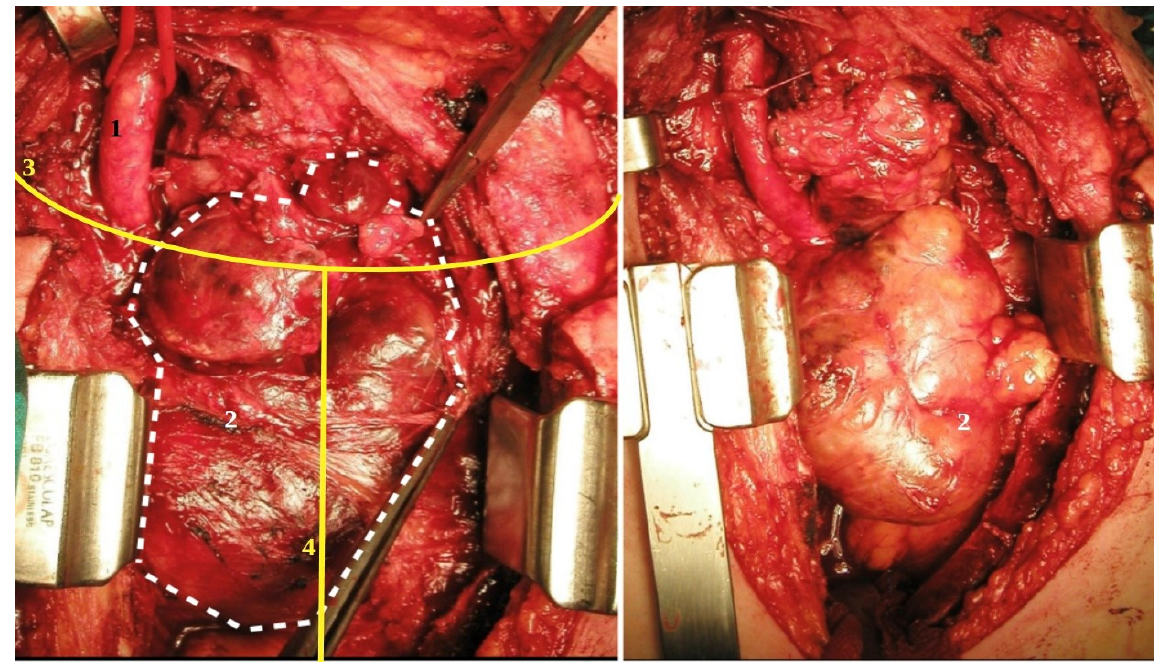
Figure 3. Cervicotomy and sternotomy for endothoracic goitre: (( 1 ) common carotid artery; ( 2 ) en- dothoracic anterior goitre; ( 3 ) cervicotomy; ( 4 ) sternotomy).